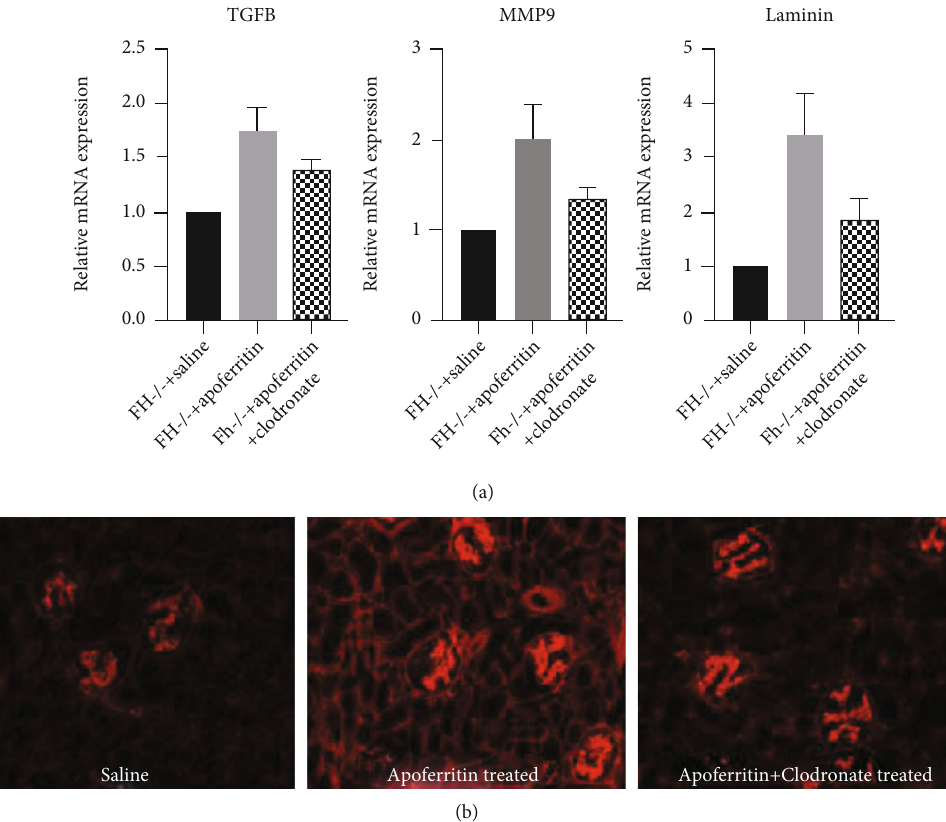
Figure 7: Laminin deposition in FH-de fi cient kidneys with ICGN is reduced by M ϕ s depletion. (a) qRT-PCR for TGFB, MMP9, and laminin from the kidney mRNA isolated from mice after 5 weeks of saline and apoferritin and 3 weeks of clodronate. The expression is normalized to GAPDH ( n = 6 /group). (b) Representative IF photomicrographs for laminin staining in the kidneys of the same groups of mice. ∗ P < 0 : 01